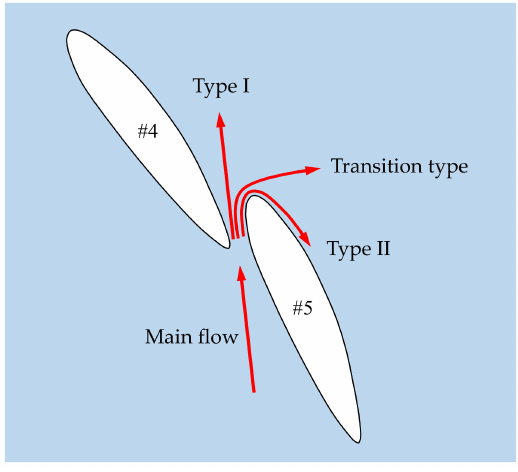
Figure 9. A schematic diagram of the flow pattern definitions.